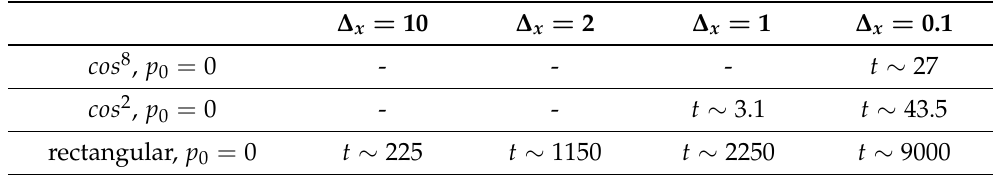
Table 1. Time for which the fraction of the probability density propagating beyond the light cone remains above 10 − 4 , for different initial